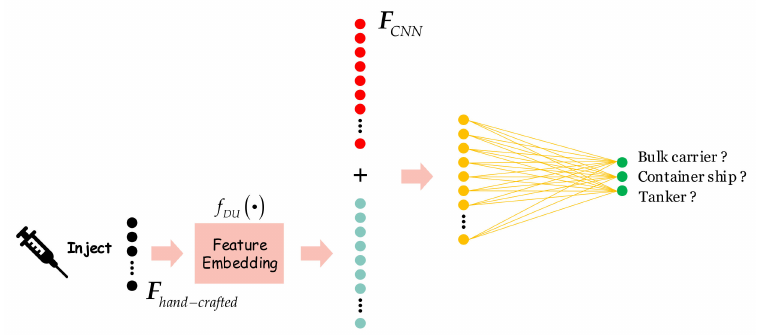
Figure 13. Diagrammatic sketch of the dimension unification adding (DU-Add).